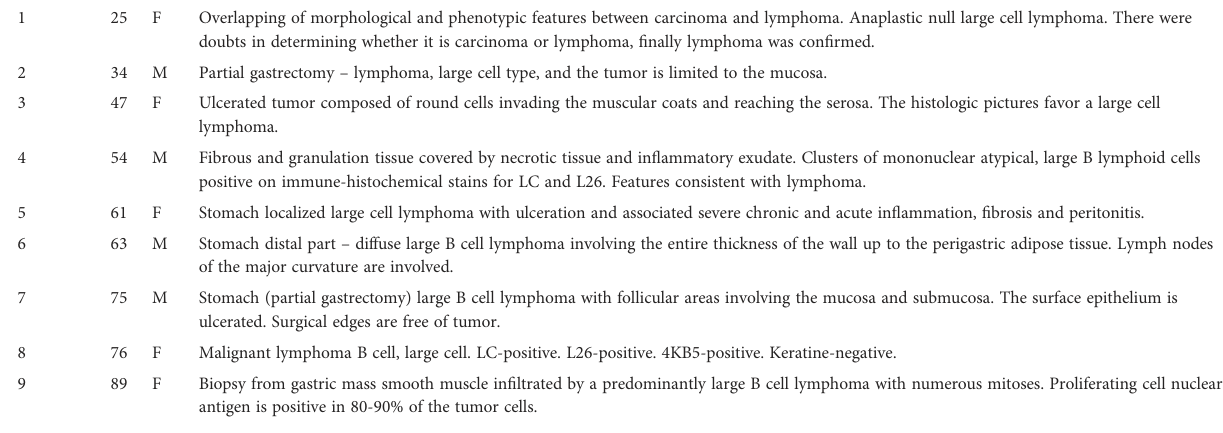
TABLE 1 Gastric DLBCL biopsy information. Sample Age